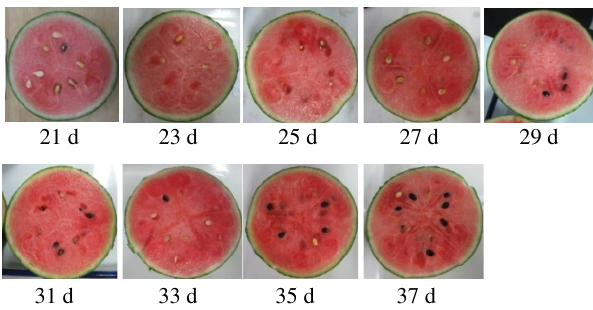
Fig. 2. Texture and color development of the watermelon varieties during the ripening process from 21 d to 37 d after